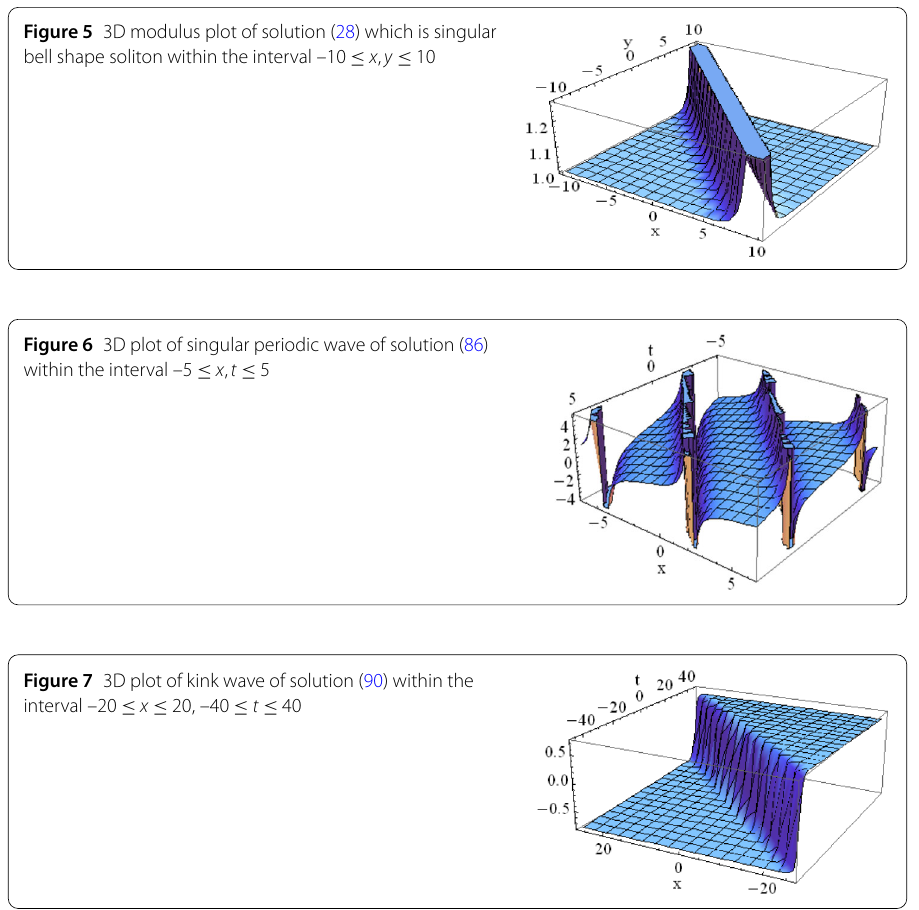
Figure 7 3D plot of kink wave of solution (90) within the interval –20 ≤ x ≤ 20, –40 ≤ t ≤